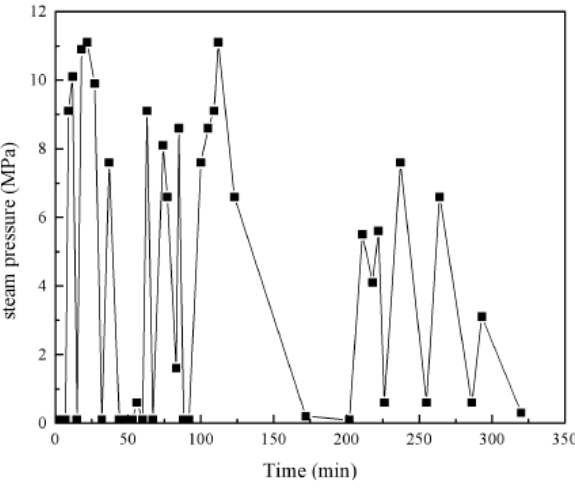
Figure 6. Variation in steam pressure with pyrolysis time.